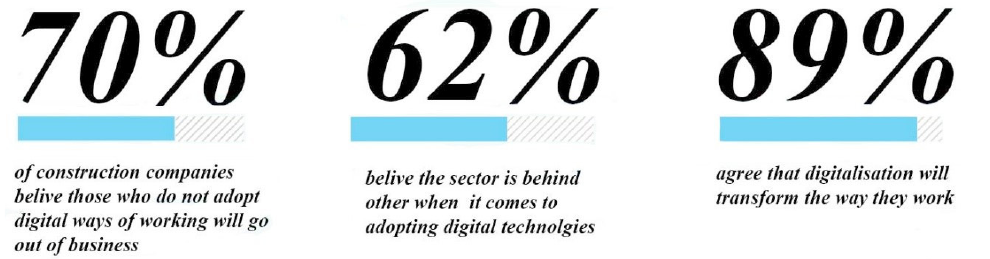
Figure 1. Analysis of the construction situation in 2019.